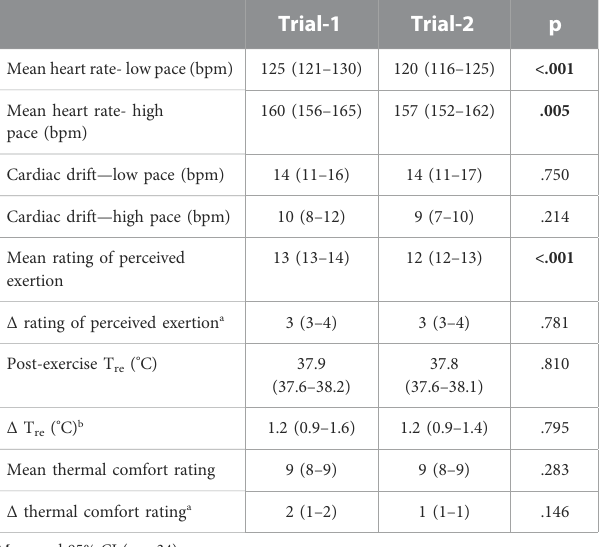
TABLE 1 Indices of physiological strain measured during Trial-1 and Trial-2 in response to 2 h high intensity interval exercise in temperate ambient